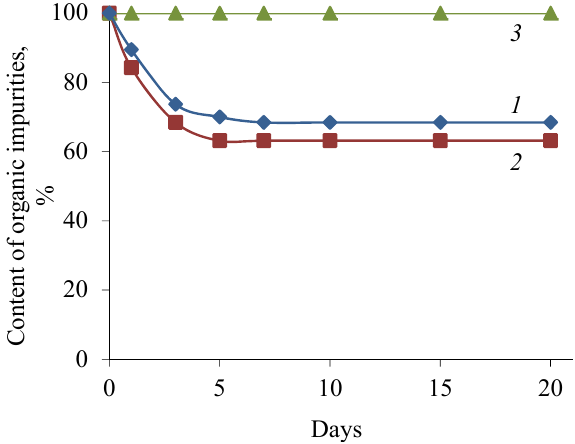
Fig. 6. Change in the content of trichlorethylene ( 1 ), dichloroethane ( 2 ) and chloroform ( 3 ) in water in the presence of citric acid over time.